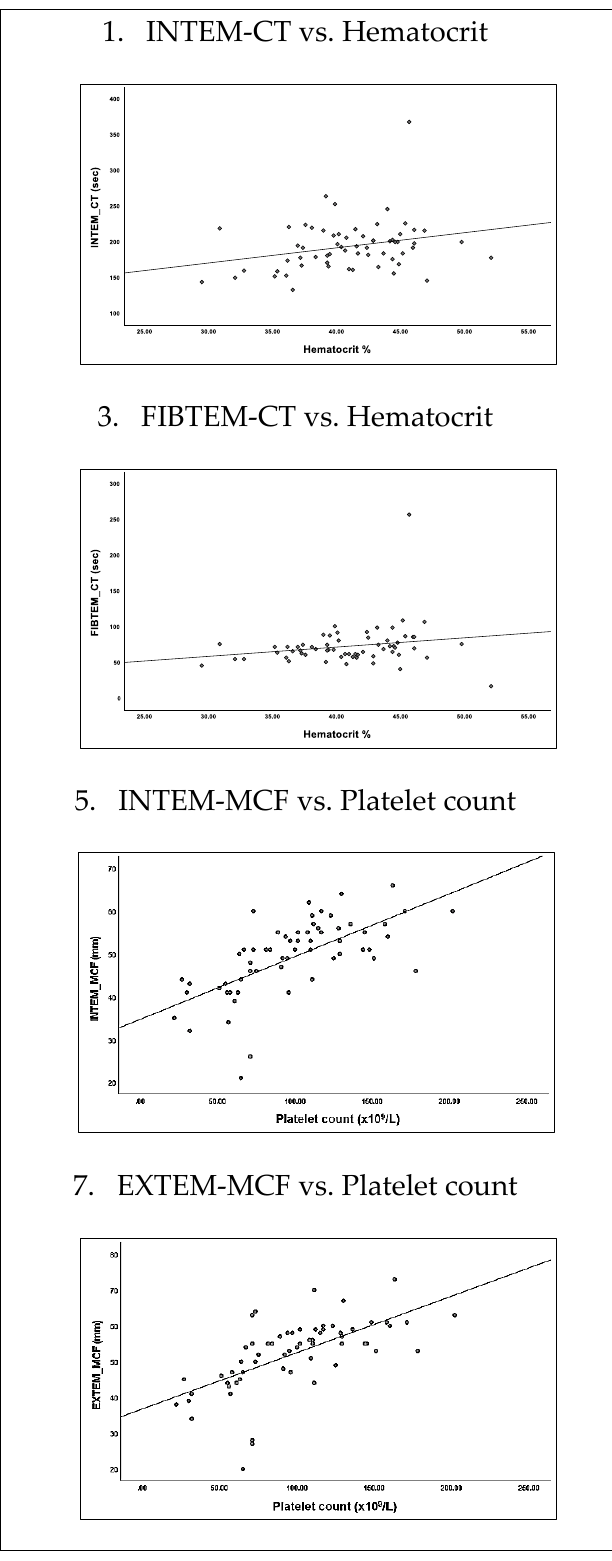
Figure 2. Association of “hematocrit increase” and “platelet decrease” during febrile phase with ROTEM and platelet function.